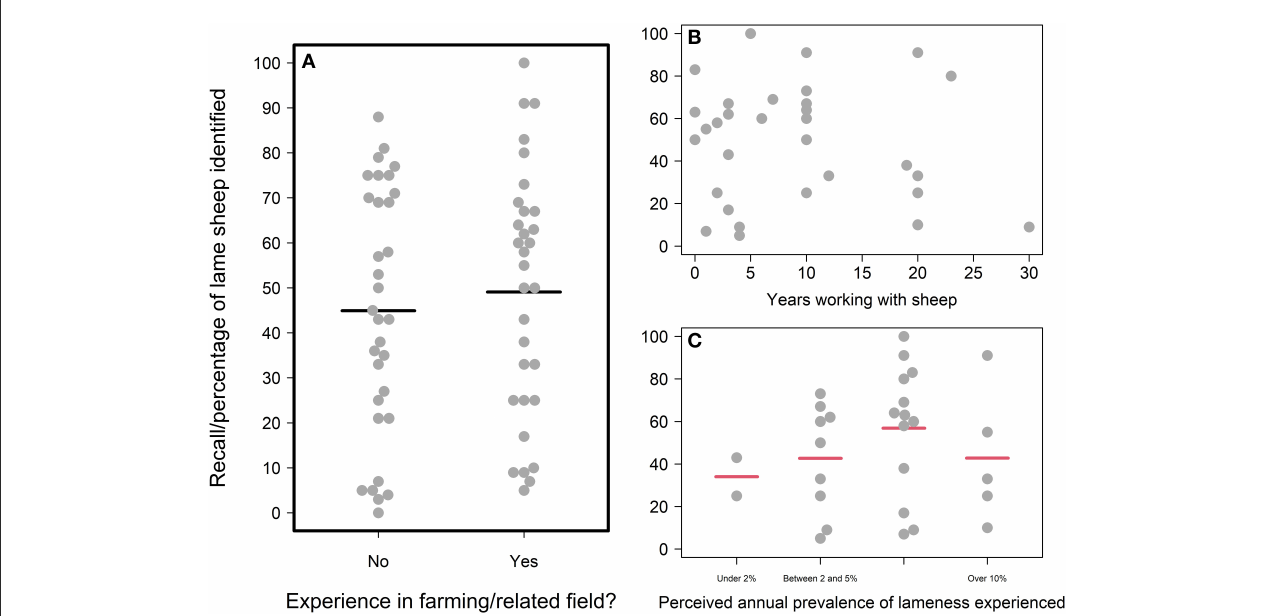
FIGURE3 Relationships between participants’ recall scores and their real-life farming experience. (A) Recall scores of those without and with farming experience; (B) Recall scores and years of farming experience spent working with sheep (for participants with farming experience). (C) Recall scores according to the perceived levels of lameness experienced in real-life flocks (for participants with farming experience who answered this question). For categorical variables, individual participant data points are jittered using the beeswarm algorithm (R Package “beeswarm”) and mean recall scores are plotted as bold horizontal lines underneath the data points. Mean recall scores colored red are those likely to be poor estimates due to small sample sizes i.e., the lower or upper quartile exceeds the 95% confidence limits of the mean. The plot is framed in a bold outline if that relationship was formally tested